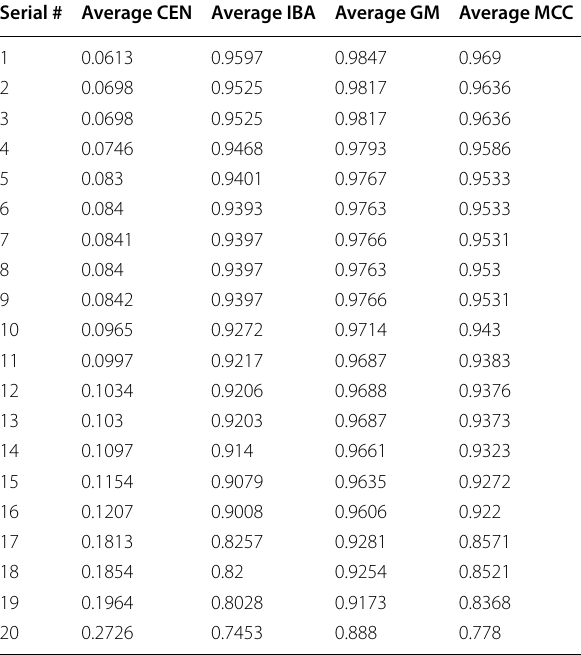
Table 7 Average values of CEN, IBA, GM and MCC performance metrics for the